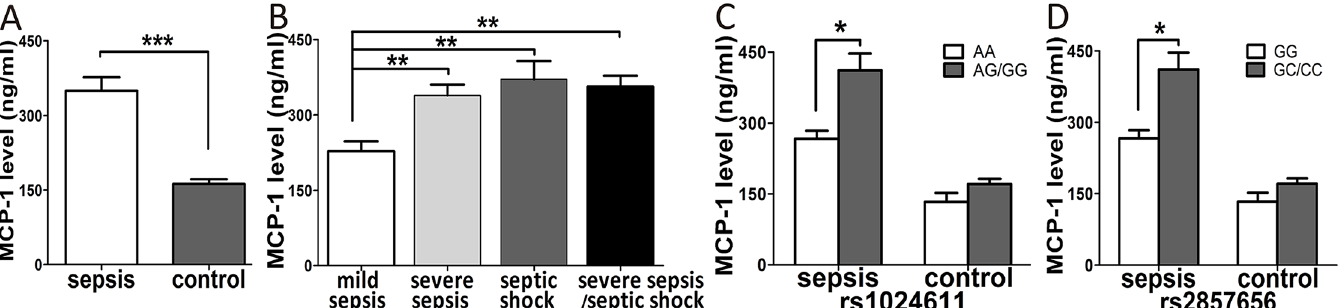
Fig 3. The plasma concentration of MCP-1 in sepsis patients (n = 80) and healthy controls (n = 80). The plasma concentration of MCP-1 in sepsis patients and healthycontrols (A), and the plasma concentration of MCP-1 in mild sepsis, severe sepsis and septic shock subgroups(B). The distributionof the plasma concentration of MCP-1 in groups of sepsis patients with different rs1024611genotypes (C) and different rs2857656 genotypes(D). The horizontal line stands for the medianconcentration with each group. * P < 0.05; ** P < 0.01; *** P < 0.001.